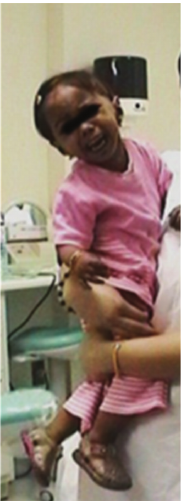
Figure 3: A Sanjad-Sakati 11-year-old